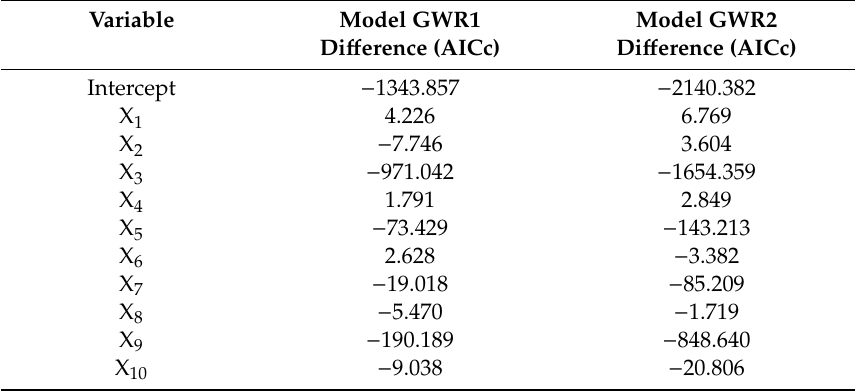
Table 5. Results of the variability test for GWR model coe ffi